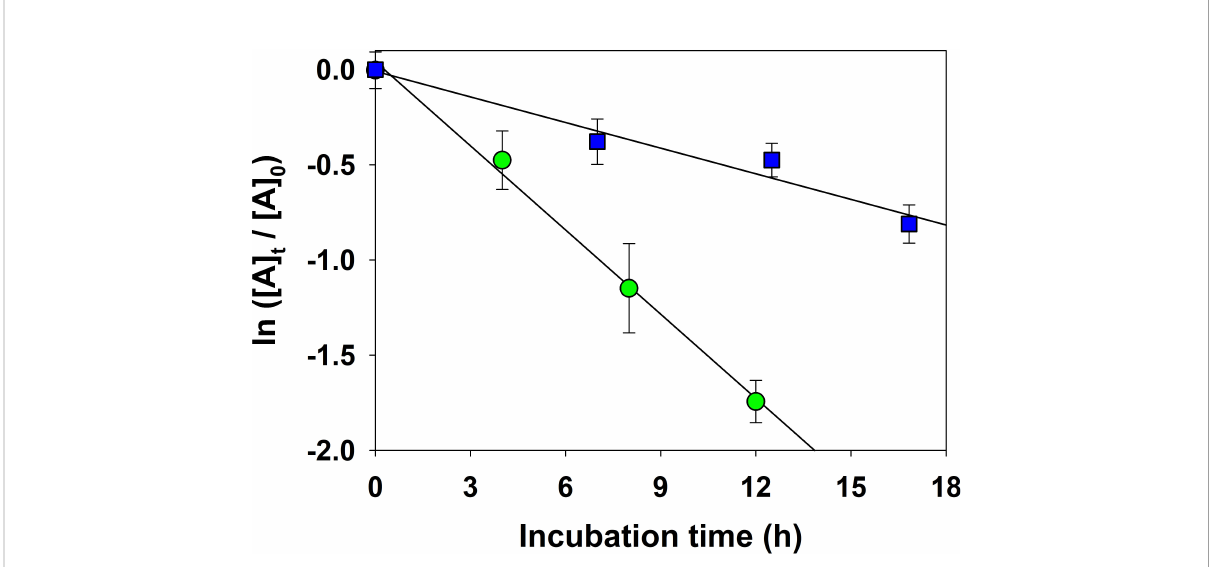
FIGURE 7 First-order kinetic plot for the net biological consumption of acrylate d in seawater samples collected from the back reef (green circles) and open ocean (blue squares). [A] 0 is the initial acrylate concentration and [A] t is the concentration of a subsample collected during each dark incubation at time t. Error bars denote the standard deviation from triplicate incubations. The biological consumption rate constant, k bio,acrylate , was determined by taking the slope of the best- fi t line from linear regression